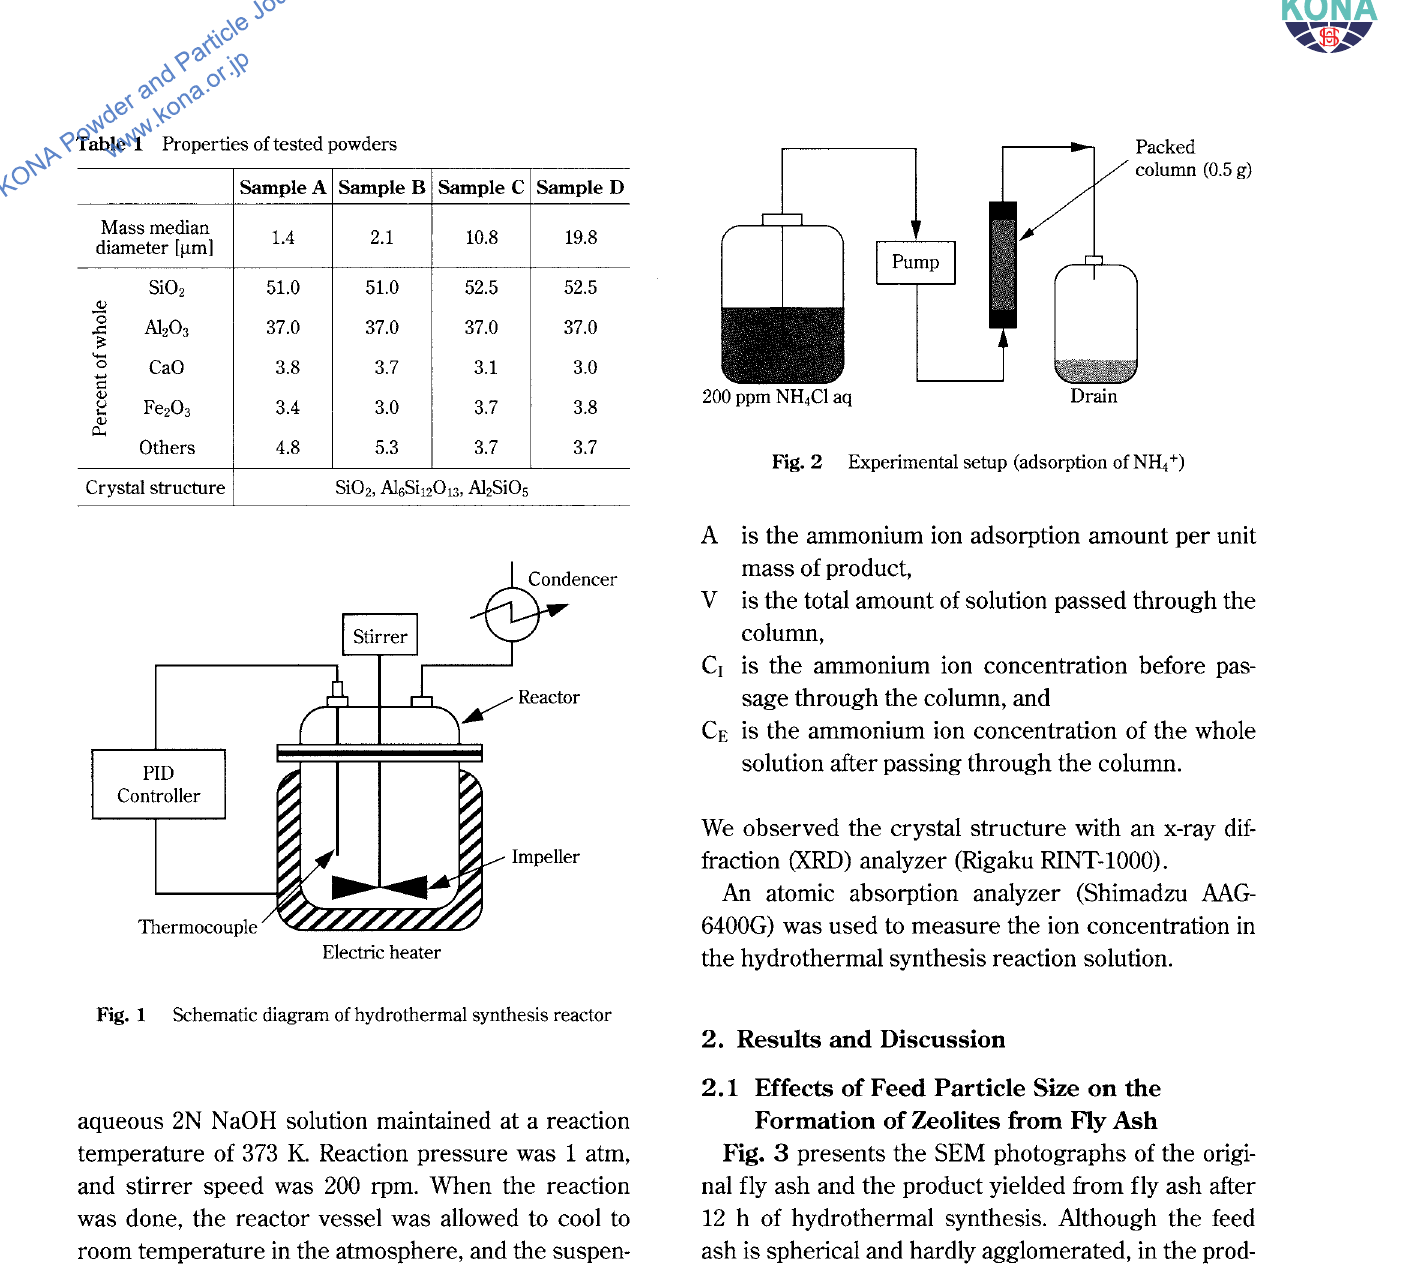
Table 1 Properties of tested powders